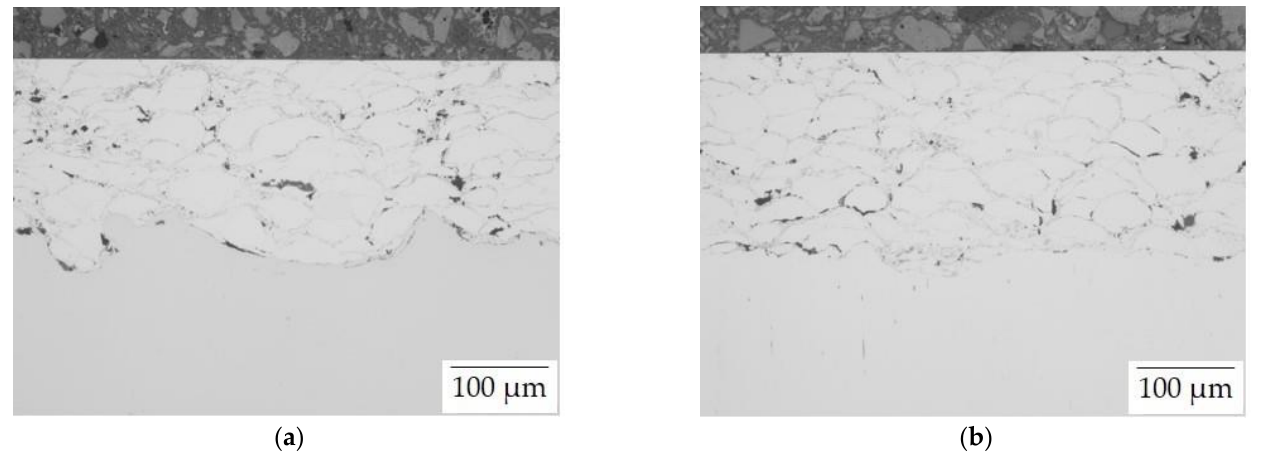
Figure 3. Light microscopic comparison of the AISI 316L coatings deposited by HVAF process on ( a ) mild steel and ( b ) stainless steel in the polished surface finish state before corrosion